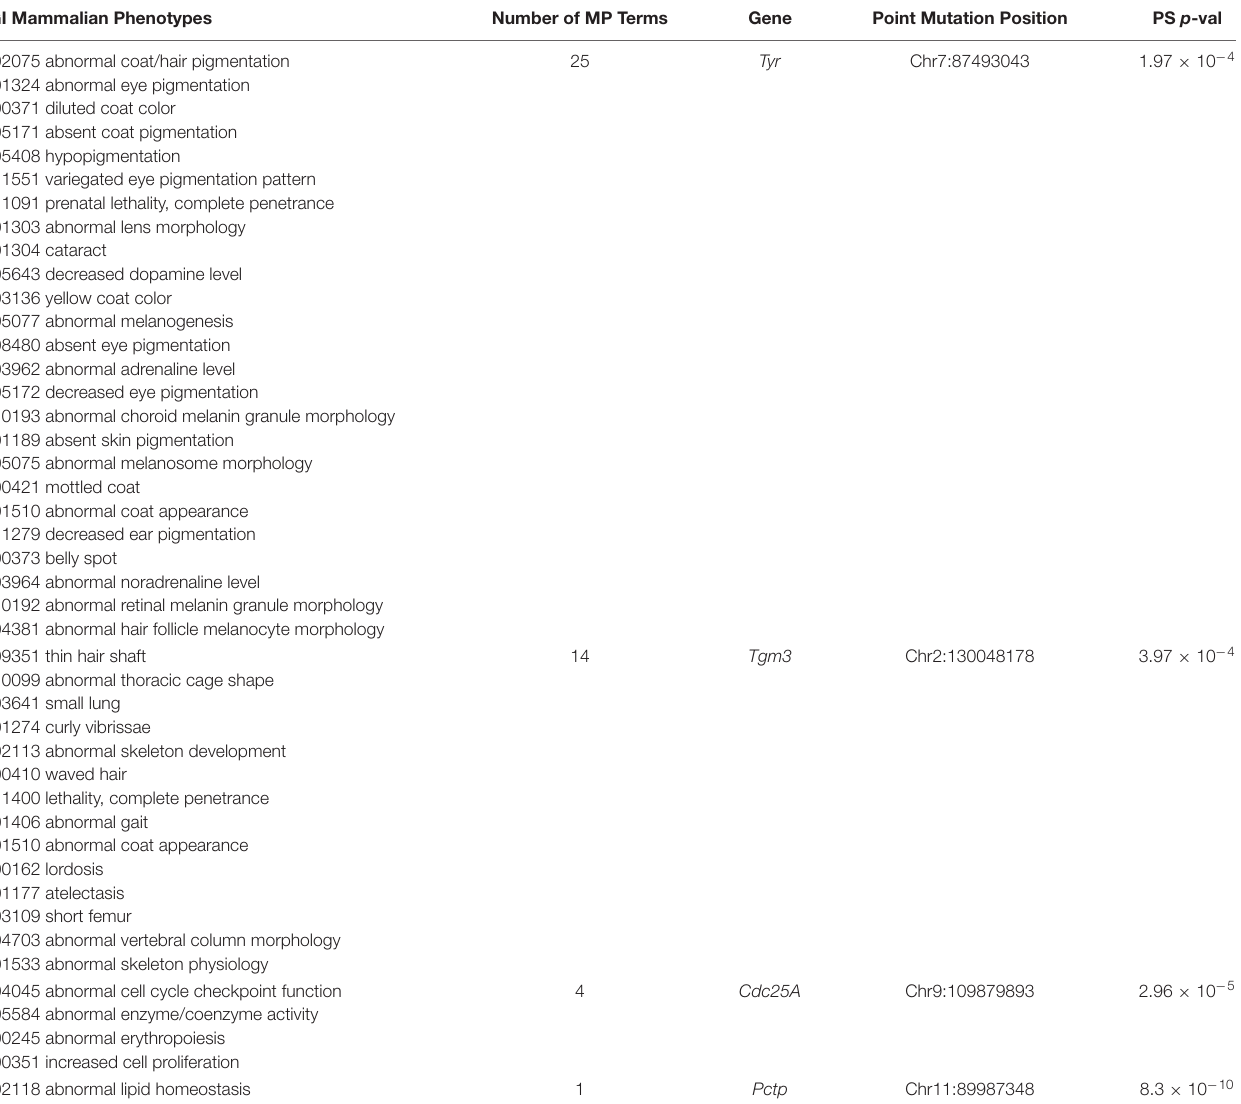
TABLE 3 | Population structure (PS) analysis was performed on causative SNP alleles for 44 mammalian phenotypes (MP) that were annotated in the Mouse Genome Informatics (MGI) database. MGI Mammalian